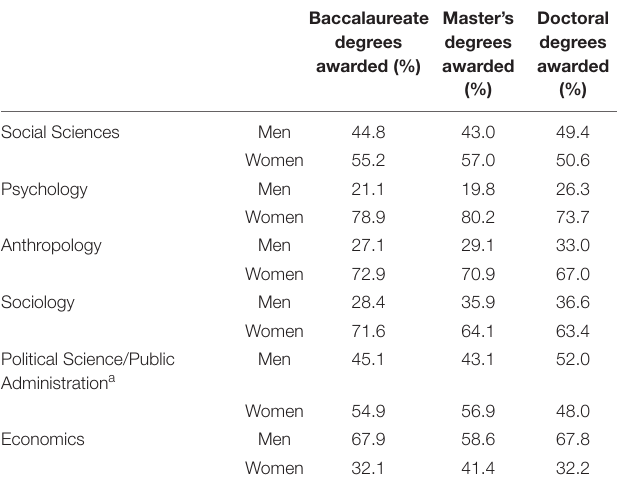
TABLE 1 | Gender representation in social science degree